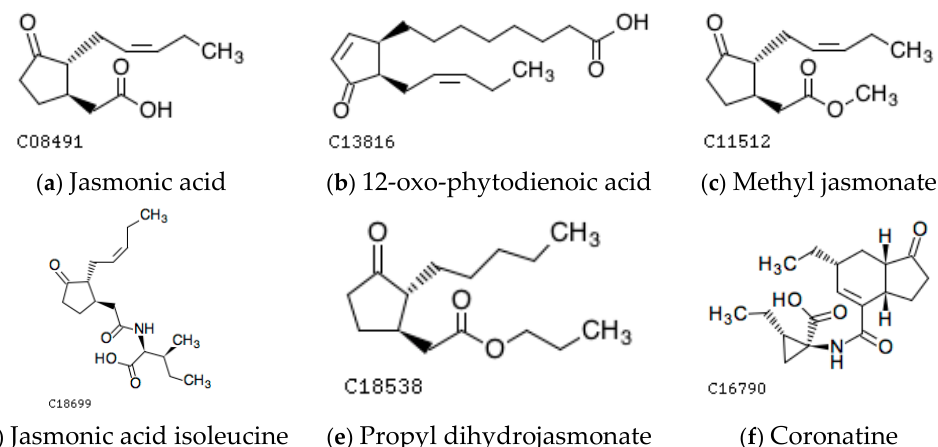
Figure 1. The representative structure of molecules of jasmonates (JAs). The JAs include jasmonic acid (C08491), 12-oxo-phytodienoic acid (C13816), methyl jasmonate (C11512), jasmonic acid isoleucine (C18699), propyl dihydrojasmonate (C18538), and coronatine (C16790), which can be retrieved from the website of KEGG (https://www.kegg.jp/, accessed on 1 March 2023).